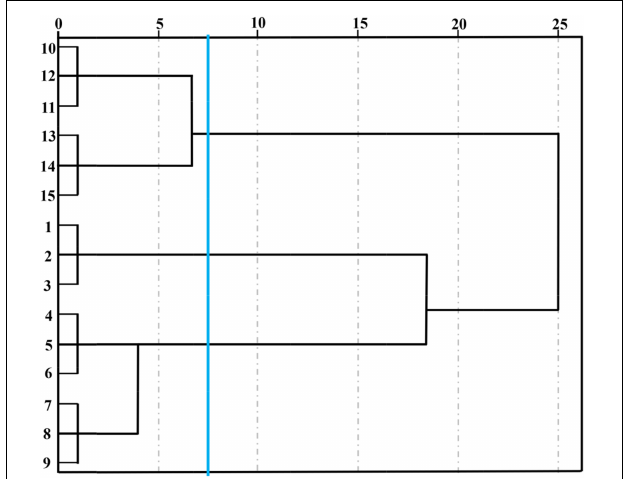
FIGURE 8 | Hierarchical cluster analysis of cut lily flowers during the postharvest process based on the composition and content of their volatile compounds. Note: cut lilies on day 0 (1, 2, 3), on day 2 (4, 5, 6), on day 4 (7, 8, 9), on day 6 (10, 11, 12), and on day 8 (13, 14,